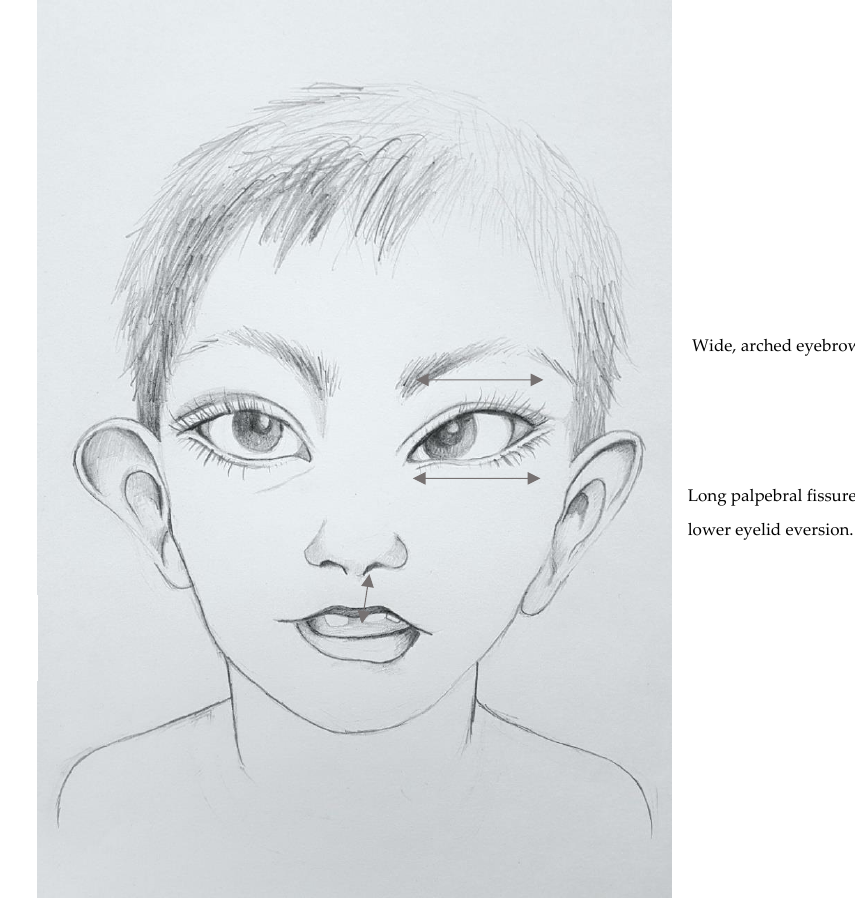
Figure 1. A child exhibiting cardinal Kabuki syndrome facial dysmorphism: long palpebral fissures with eversion of the lateral third of the lower eyelid; wide, arched eyebrows with sparseness or lack of the lateral third; short columella (lower part of the nasal septum) with depressed nasal tip; large, prominent or cup-shaped ears; persistent fetal finger pads.